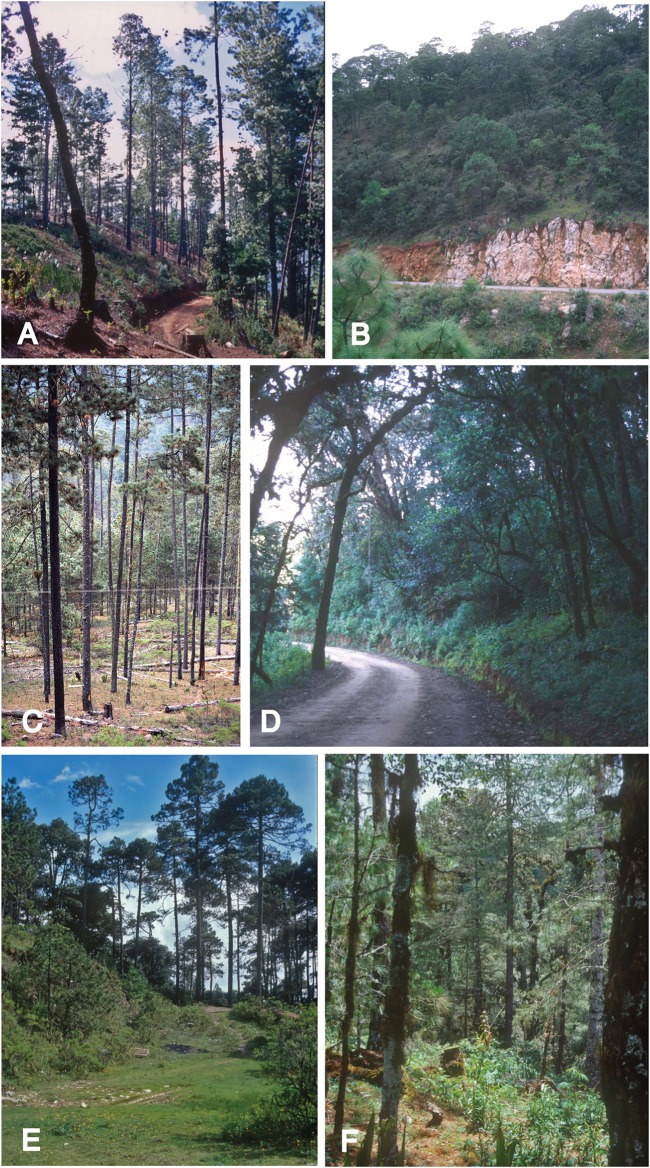
Salamander habitats in Oaxaca, Mexico.(A) 1.7 km (by road) N of San Miguel Suchixtepec, a locality for Thorius pinicola, 25 January 2001. This forest is heavily logged and only three salamanders were found here this day. All were found between the bark and wood of upright stumps. The type locality is 5 km (by road) further north. (B) 19 km S of Sola de Vega, the type locality of T. longicaudus, 15 July 1976. Salamanders were abundant here in the 1970s, but by the 1990s the population had declined. No specimens of this species have been observed since October 1997, despite several visits to this and nearby localities. (C) 29.5 km (by road) SE of Tlaxiaco on road to San Miguel, less than 2 km from the type locality of T. tlaxiacus, 5 December 1978. Eighty specimens of T. tlaxiacus and T. narisovalis were collected here that day, mostly from within fallen logs. (D) 1.1 km W of Santo Tomás Teipan, the type locality of T. minutissimus, 23 January 2001. The previous evening, two salamanders were found in the road bank visible in the lower middle of the photograph. (E, F) Cerro San Felipe, the type locality of T. narisovalis, 4 August 1999. E—3 km north of La Cumbre; F—Corral de Piedra. Salamanders were found under bark on large fallen logs. (A–C) Photos by J. Hanken and (D–F) M. García-París.